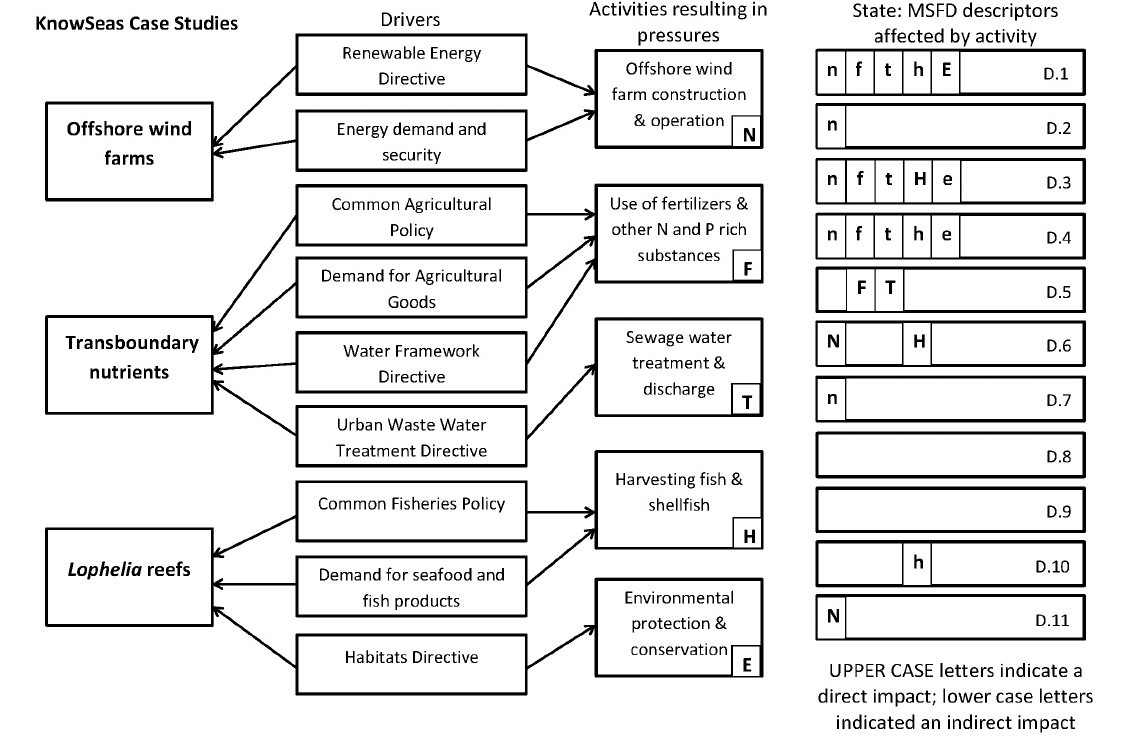
Fig. 2 . Major maritime and land-based drivers, associated human activities that result in pressures on the marine environment, and the potential direct (uppercase) and indirect (lowercase) effects on the 11 Marine Strategy Framework Directive (MSFD) Good Environmental Status (GEnS) Descriptors related to 3 case studies from the Northeast Atlantic. D1 indicates Biodiversity; D2, Nonindigenous species; D3, Commercial fish and shellfish; D4, Food webs; D5, Eutrophication; D6, Seafloor integrity; D7, Hydrographical conditions; D8, Contaminants; D9, Contaminants in fish and shellfish; D10, Marine litter; D11, Underwater